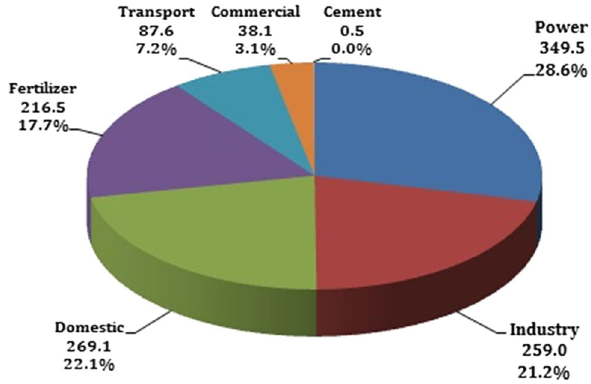
Fig. 6 Pakistan’s sector wise gas consumption Sources : HDIP